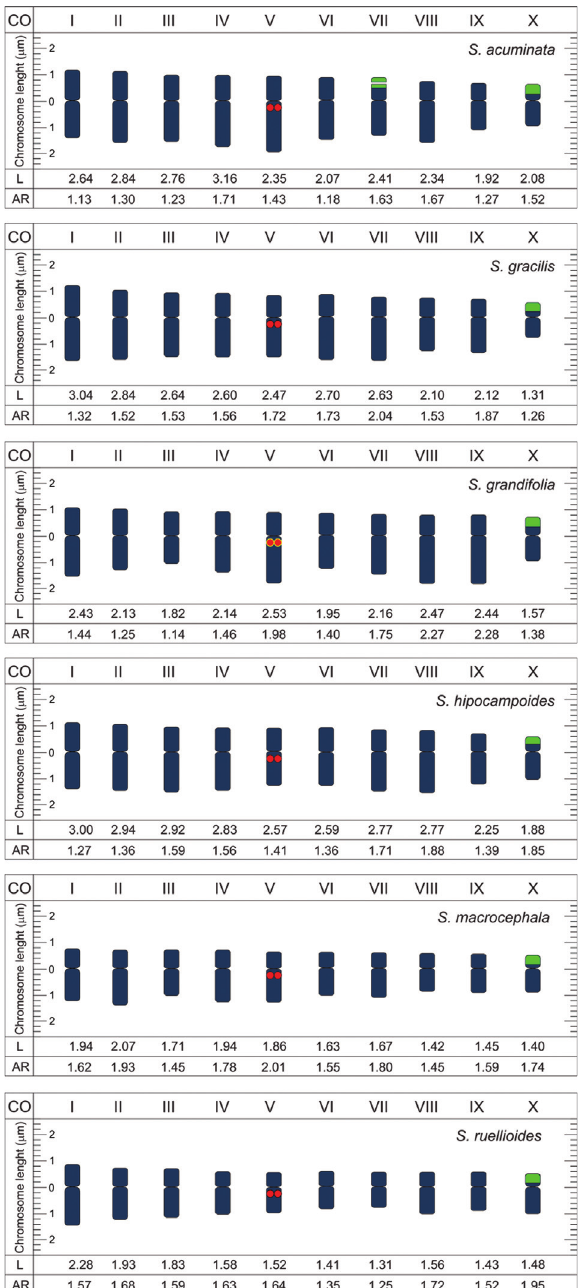
Figure 3 - Idiograms of Stylosanthes species showing chromosome length (L), arm ratio (AR), 5S (red), CMA bands colocalized with 35S r DNA sites (green), and CMA bands colocalized with 5S (yellow).